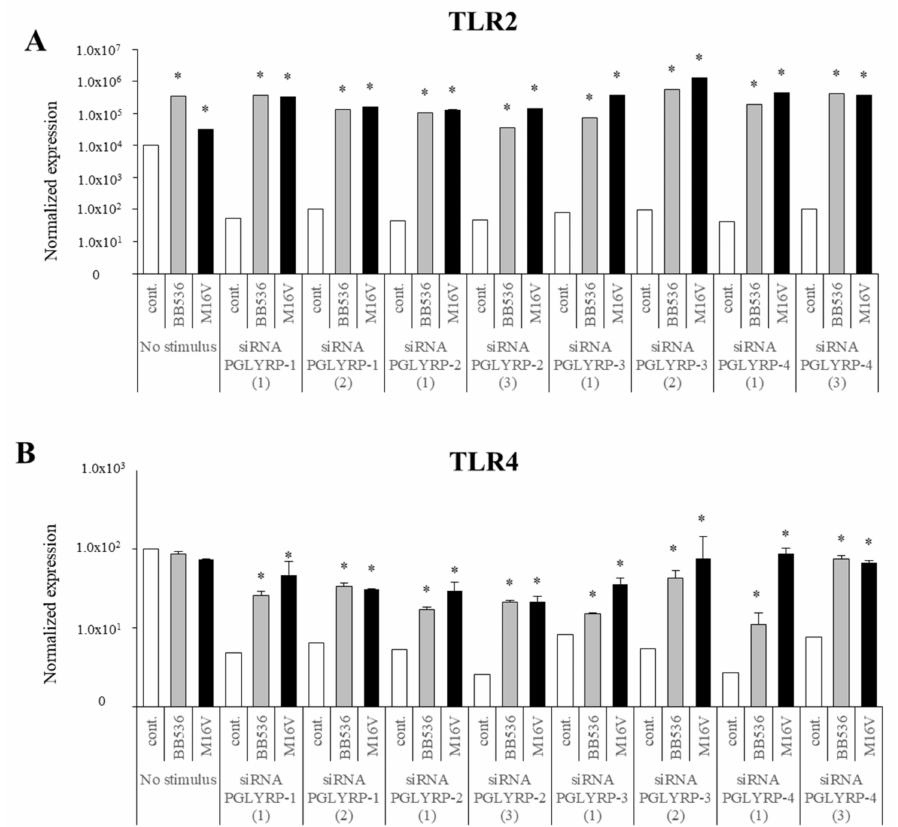
Figure 8. Paraimmunobiotic bifidobacteria-mediated expression of TLR2 and TLR4 in peptidoglycan recognition proteins (PGLYRP)-knockdown porcine intestinal epithelial (PIE) cells. Porcine TLR2 ( A ) and TLR4 ( B ) expressions in PIE cells transfected with PGLYRP siRNAs, and stimulated with Bifidobacterium longum subsp. longum BB536, or B. breve M-16V. Each mRNA level was normalized with the porcine β -actin mRNA and the normalized fold expression was determined in comparison to PIE cells with transfected negative control siRNA. The results are shown as means ± standard deviation obtained from three independent experiments ( n = 6). * p < 0.05 against